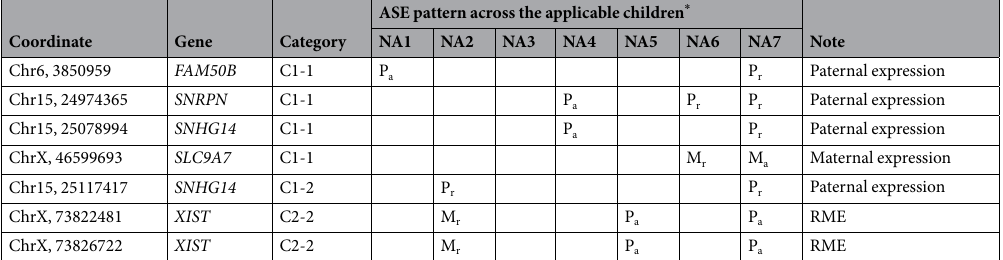
Table 2. The 7 ASE sites passing the r = a test. * The ASE pattern (see also Fig. 1) of the children from the 7 trios illustrated in Fig. 1b: NA1, NA07048; NA2, NA10847; NA3, NA10851; NA4, NA12877; NA5, NA12878; NA6, NA19129; NA7, NA19240. A blank represents that the site of the corresponding individual is not applicable, e.g., heterozygous variant was not observed or the number of the mapped RNA-seq reads was not greater than ten on the site of the